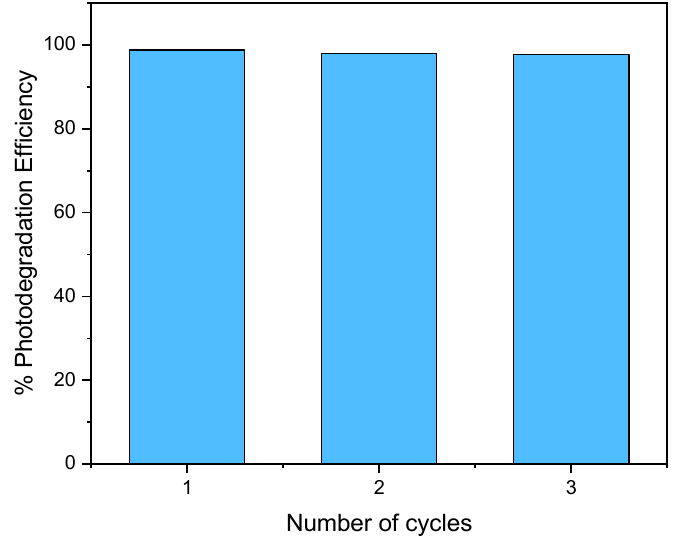
Figure 12. Recyclability evaluation of catalyst for 3 repeated experiments.